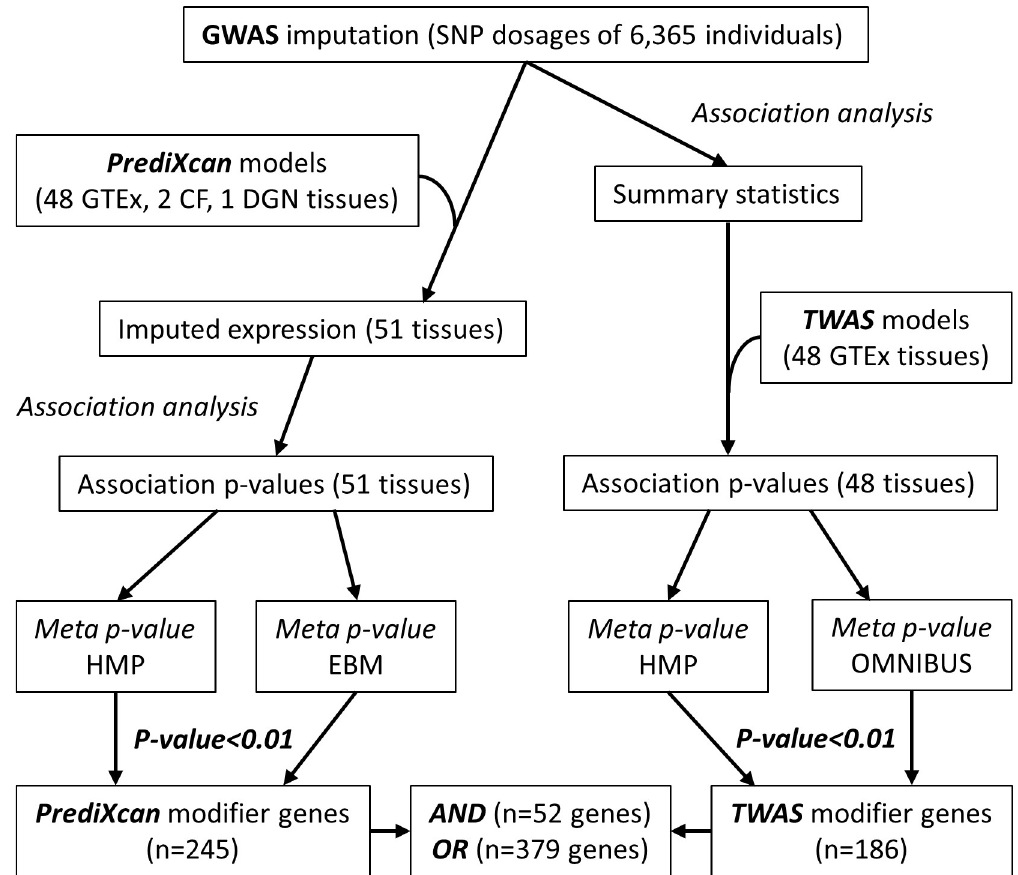
Fig 1. Analysis workflow overview. GWAS imputation of SNP variances in CF patients (n = 6,365) were used to impute genetically regulated gene expression, which were then tested for CF lung disease severity using either the PrediXcan platform (left arm), or TWAS (right arm). The association results from multiple tissues from each platform were combined through 2 different meta-analysis of multiple p-values from different tissues. GTEx : Genotype-Tissue Expression RNA-seq (n = 48 tissues); CF : LCL microarray (n = 753 samples), and nasal epithelial biopsy RNA-seq (n = 132 samples); DGN : Depression Genes and Networks RNA-seq from whole blood (n = 922 samples); HMP : harmonic mean p-value; EBM : empirical adaptation of Brown’s method; OMNIBUS : omnibus p-value from